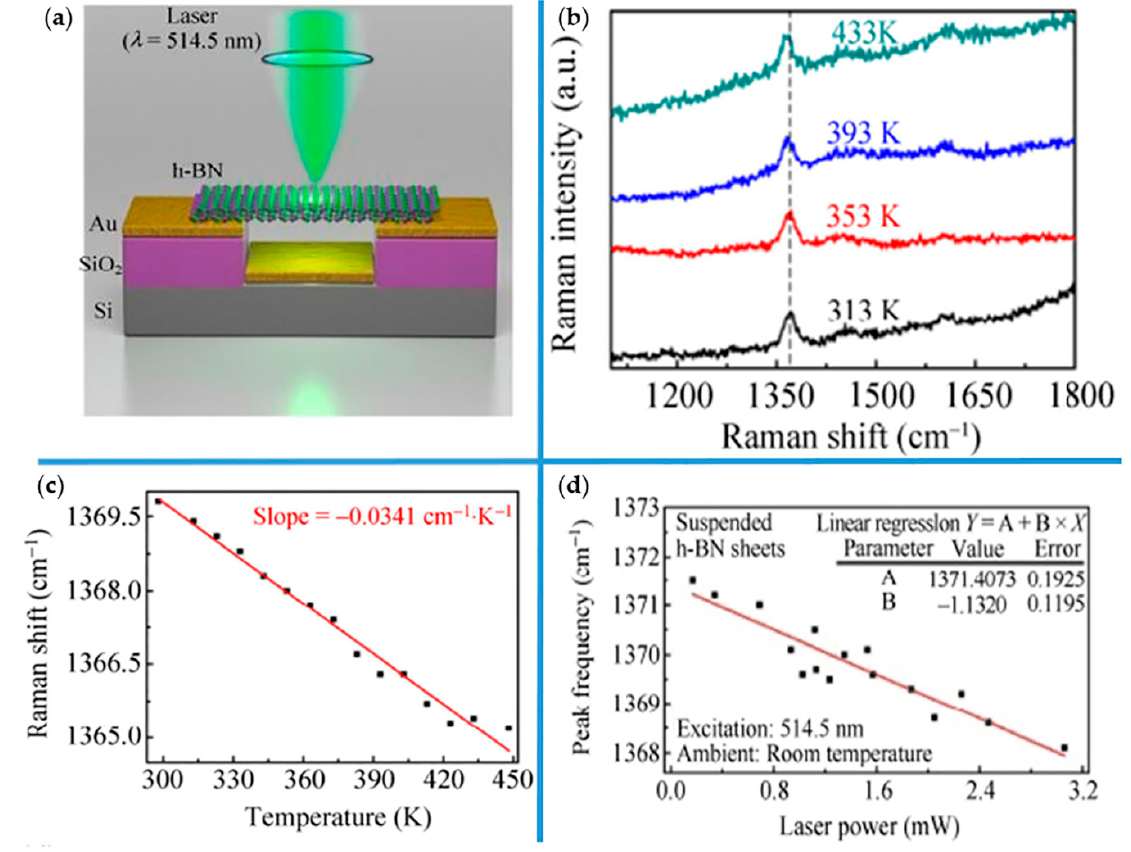
Figure 6. The group diagram for measuring the thermal conductivity of single layered h-BN sheet by micro-Raman spectroscopy. ( a ) Schematic of experiment model for measuring the thermal conductivity of h-BN. ( b ) Raman spectrum of single layer h-BN at different temperature where Raman frequency evolution of Raman E 2g mode with a variety of temperature is clearly seen. ( c ) and ( d ) present temperature- and laser power-dependent peak frequency of E 2g mode in suspended h-BN sheets, respectively. The explanation of the fitted lines and inserted chart are similar to Figure 5. Reproduced with permission from [108]. Copyright 2014, Springer International